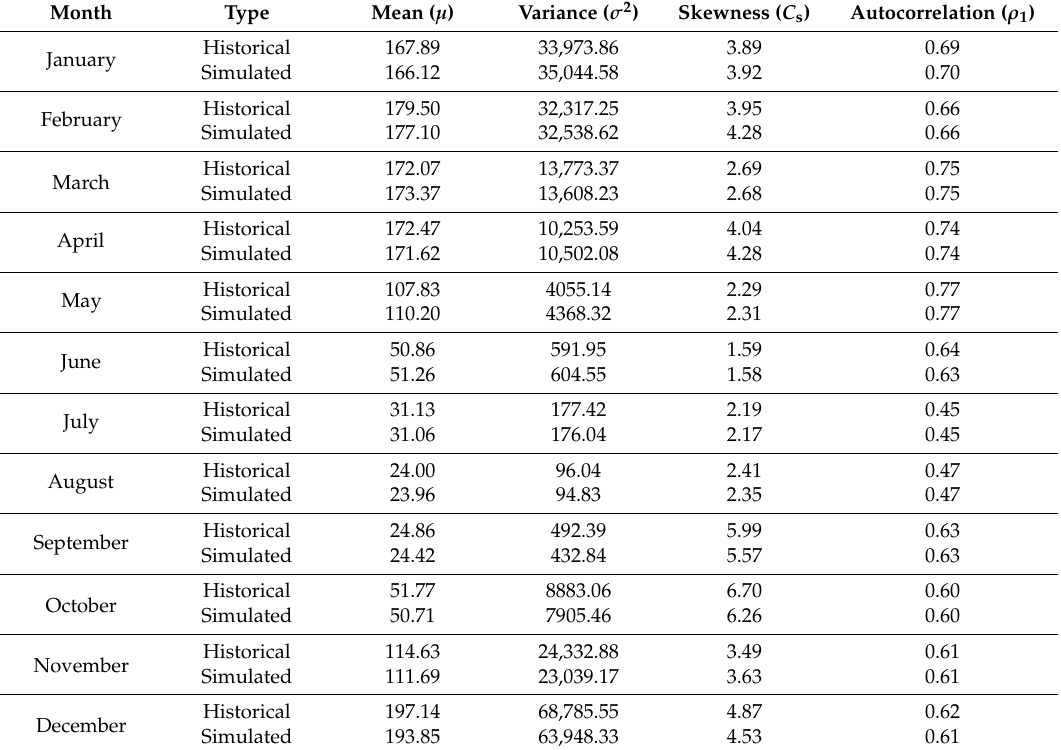
Table A4. Monthly-based summary of historical and simulated (synthetically generated using an AR(1) with P III white noise) statistics of the real-world case study employed in Section 3—“Real world case study” of the main